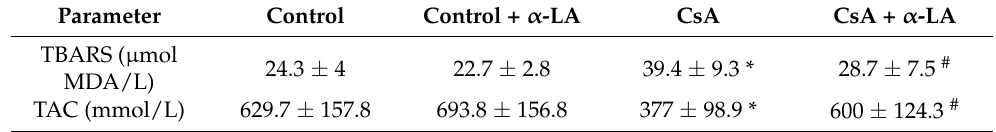
Table 2. Effect of α -LA administration on serum oxidative stress in CsA-treated animals.